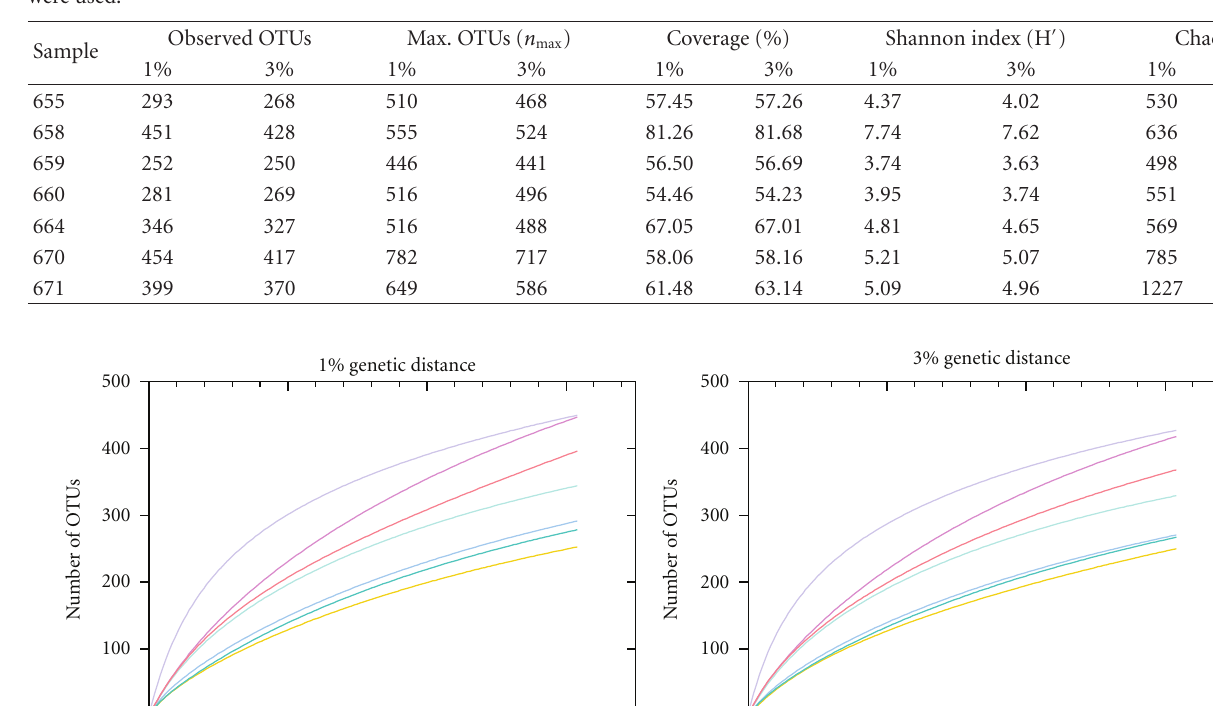
Table 3: Archaeal diversity and richness values at 1% and 3% genetic distance. Numbers of observed OTUs as well as Shannon and Chao1 values were calculated with QIIME [16]. The maximal OTU number ( n max ) in each sample was calculated by nonlinear modeling. Coverage was determined based on observed OTUs and n max . To compare community structures, 3100 randomly selected sequences form every sample were used.